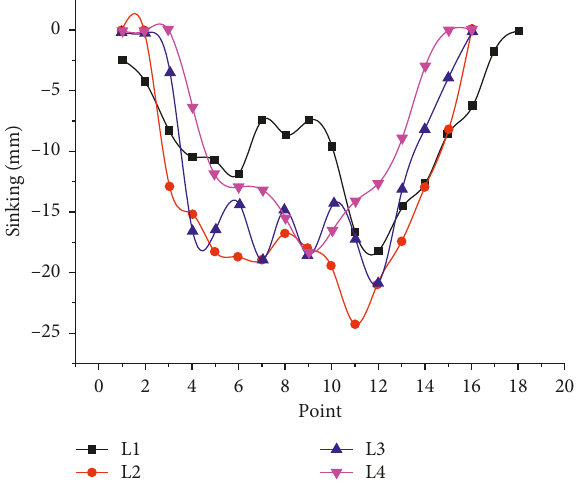
Figure 12: Subsidence with the filling method.